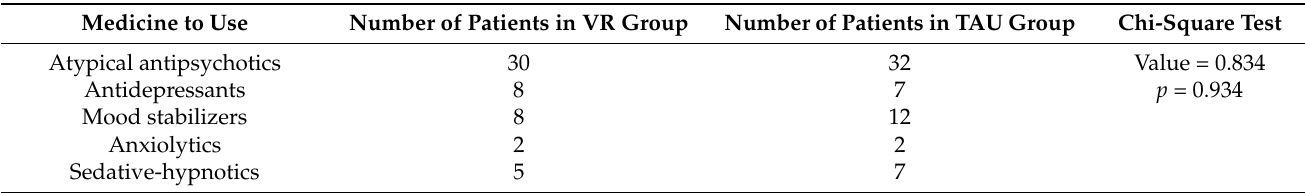
Table 2. The medication regime of two